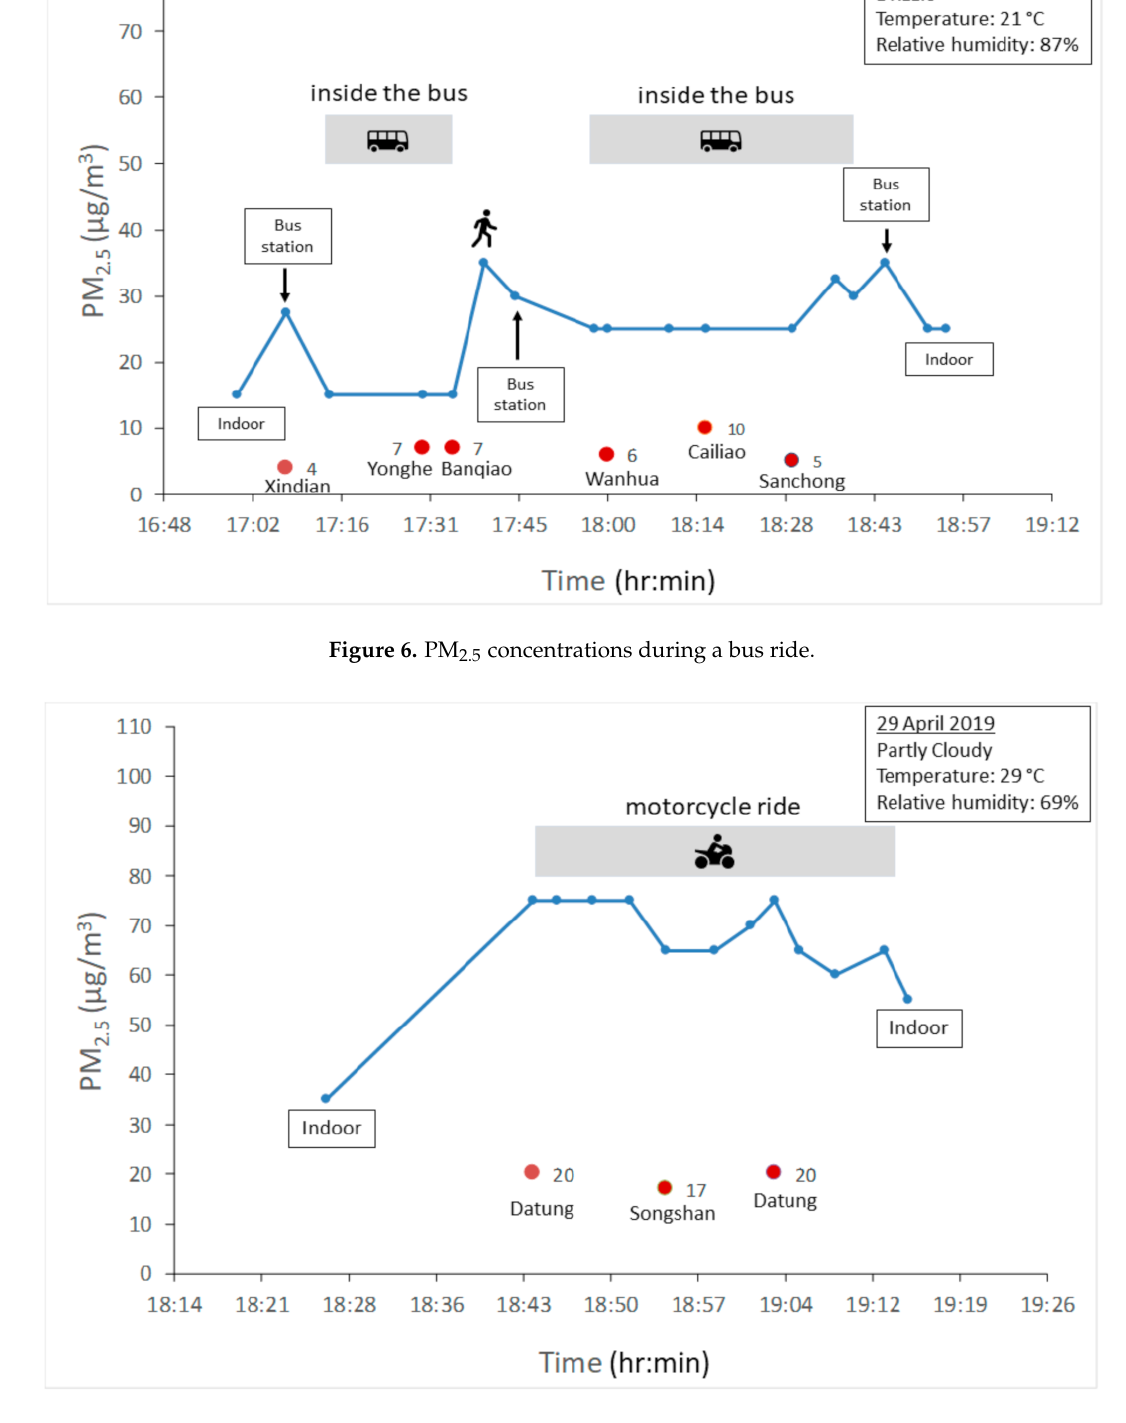
Figure 7. PM 2.5 concentrations during a motorcycle ride on a major road. There were five car trips. The PM 2.5 concentrations were lower compared to those during walking (median: 15 µ g/m 3 ; range: 8–80 µ g/m 3 , n = 111 measurements, p < 0.0001 vs.